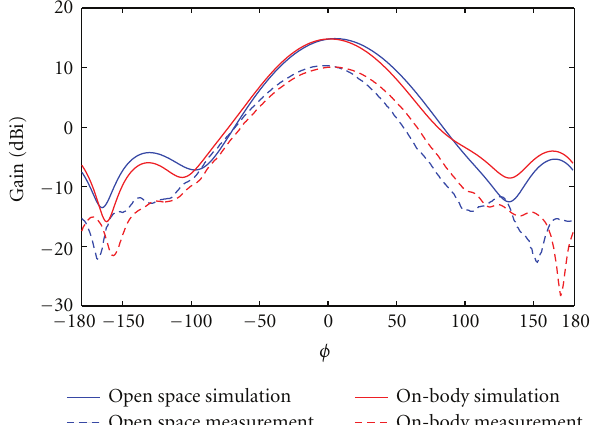
Figure 17: Gain pattern in the azimuth plane ( yz -plane) at 2.45GHz in open space and when the antenna is placed on-body in a firefighter jacket: simulations (full line) versus measurements (dashed line).